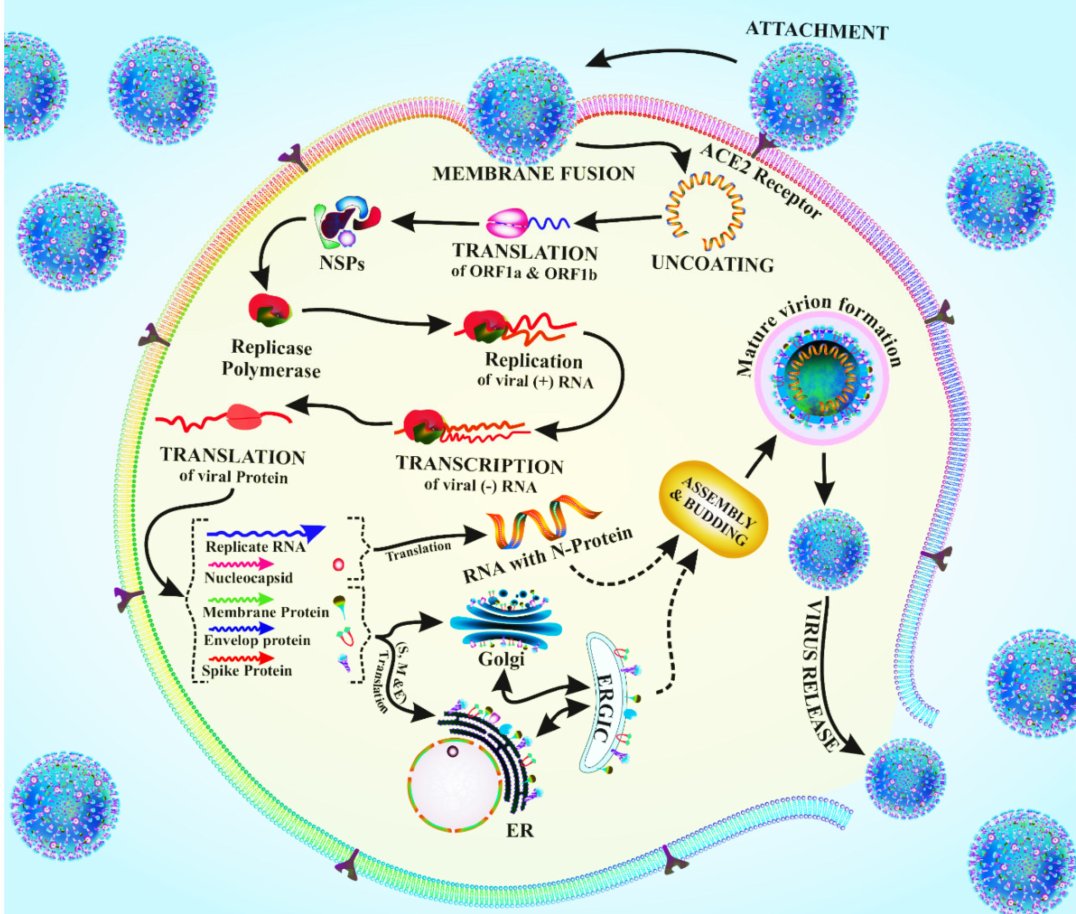
Figure 2. Schematic drawing of the viral entry and replication of the